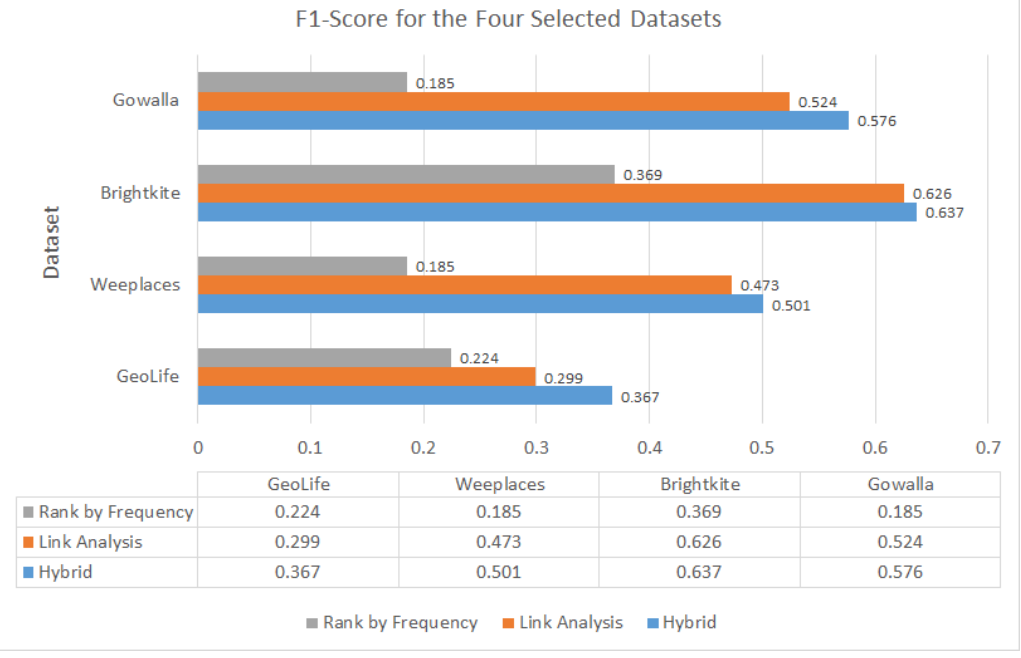
Figure 13. F 1 values obtained with the three methods.